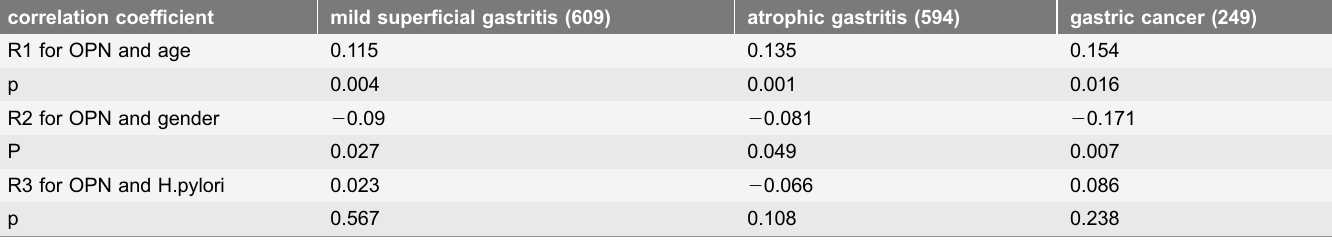
Table 3. Correlation between serum OPN levels and age, gender as well as H.pylori infection. correlation